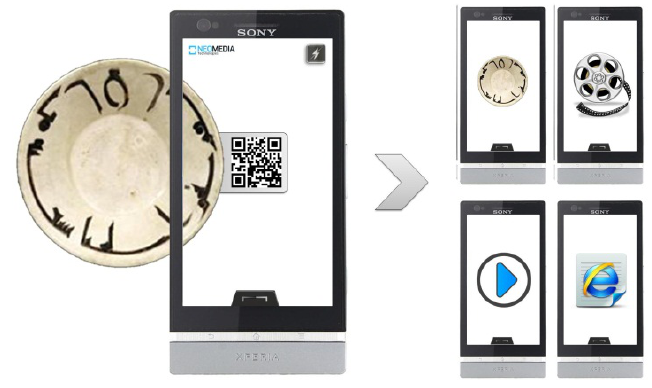
Figure 5. Identifier QR Code contains a URL address of a web page, pictures, voice or video related to